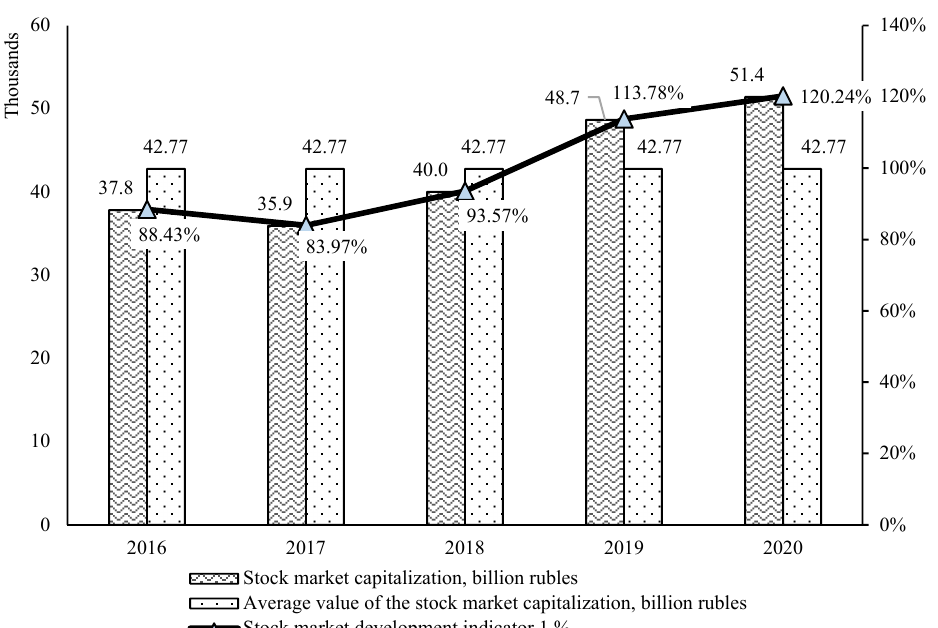
Figure 3. Dynamics of the stock market development Indicator 1 and its components in the Russian